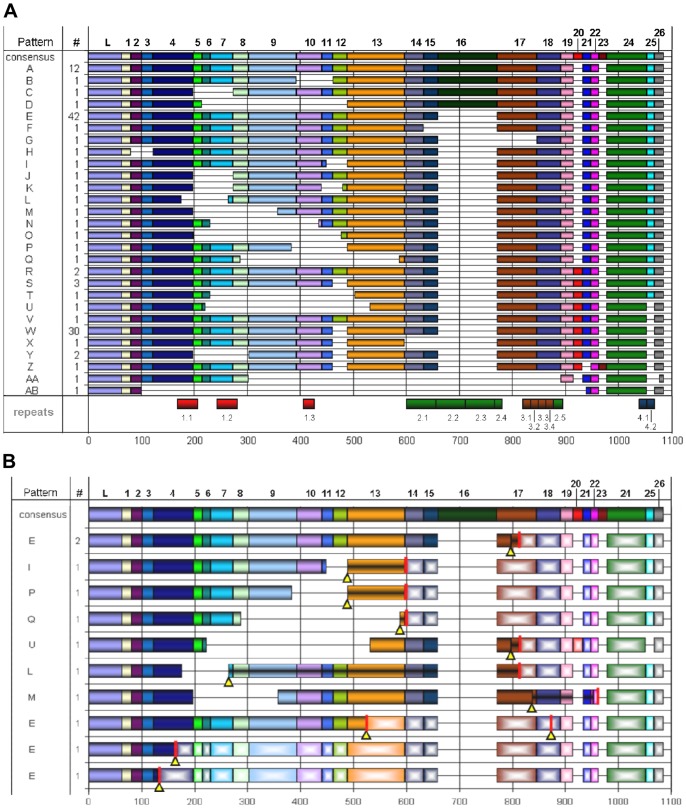
Element patterns of He185/333 cDNAs.
A. A total of 26 distinct elements (1–26 and leader (L) – see consensus pattern in the top row of the alignment) have been identified amongst He185/333 sequences, and these are arranged into 28 unique element patterns. A horizontal line indicates elements that are “missing”. The locations of sequence repeats are shown at the bottom of the figure. The numbers at the bottom of the alignments indicate nucleotide positions. B. Element patterns of He185/333 cDNAs with mutations. Sequences with the element patterns E, I, P, Q, U, L, M contained insertions, deletions or point mutations, resulting in frame shifts and/or early stop codons. Mutations are marked by black lined yellow arrowheads, early stop codons as red bars across an element. Arrowheads falling together with bars are cases of stop codons caused by point mutations, as seen in the three lower element patterns. Arrowheads and bars that are located apart from each other are cases of insertions or deletions, resulting in frame shifts and downstream early stop codons. Elements between mutations and early stop codons contain black central lines to point out missense translations, due to the frame shift. Elements after early stops are patterned with white centres to highlight non-translated regions of the cDNAs.